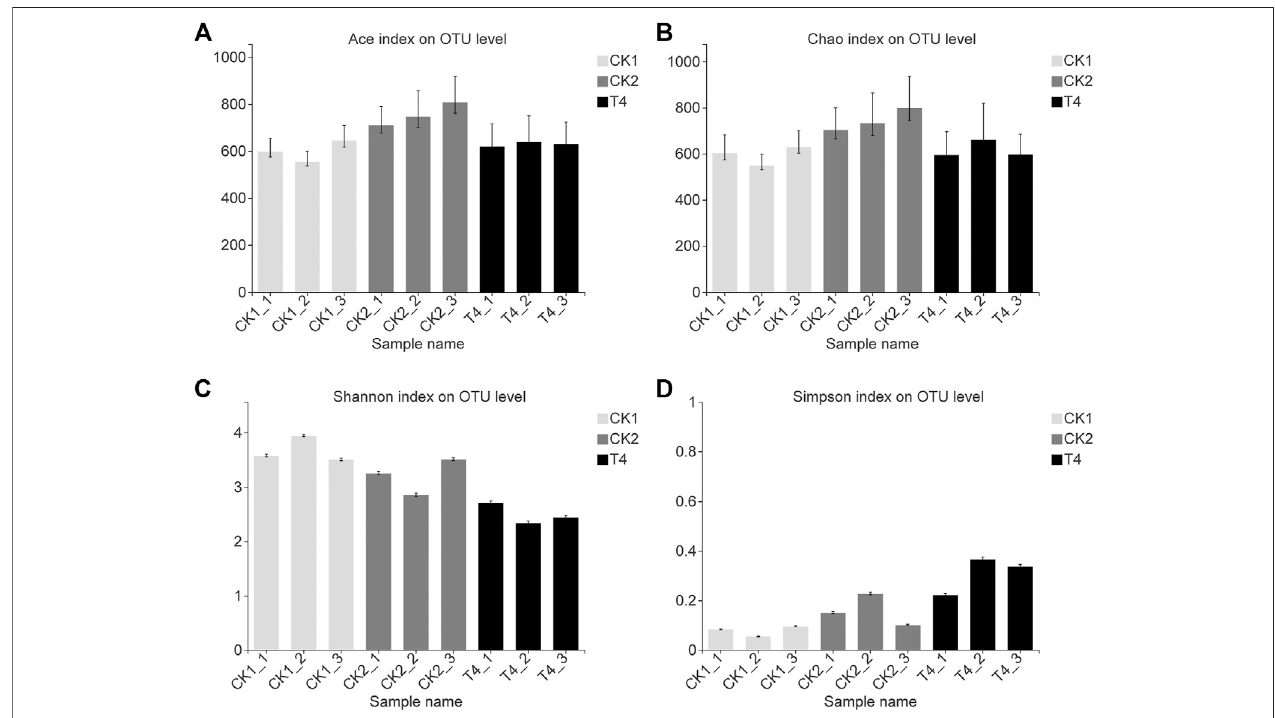
FIGURE 3 | Analysis of alpha diversity based on OTU of replant soil fungal. (A) Ace index on OTU level. (B) Chao index on OTU level. (C) Shannon index on OTU level. (D) Simpson index on OTU level. CK1: control, CK2: high standard control, T4: soil soaking. The abscissa is the sample name, and the ordinate is the observed value of a certain index type under the selected classi fi cation level. Type I intervals represent the upper and lower limits of the